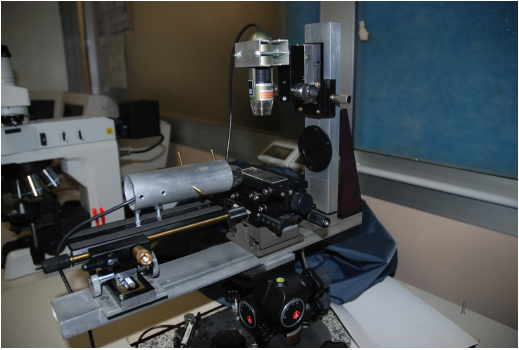
Figure 4. The wettability measurement